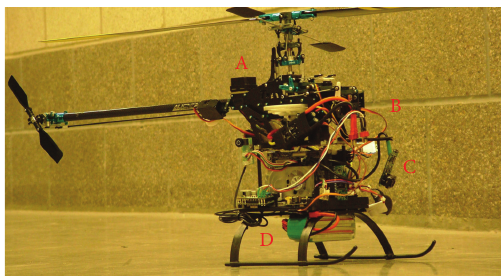
Figure 17: Saint Vertigo, the autonomous MAV helicopter, consists offourdecks.TheAdeckcontainscollectivepitchrotorheadmecha- nics, The B deck comprises the fuselage which houses the power plant, transmission, main batteries, actuators, gyroscope, and the tail rotor. The C deck is the autopilot compartment which contains the inertial measurement unit, all communication systems, and all sensors. The D deck carries the navigation computer which is attached to a digital video camera visible at the